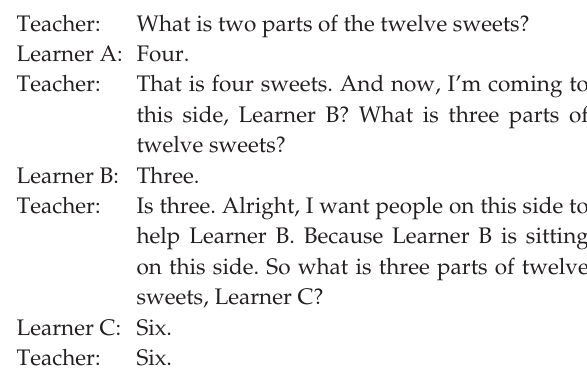
FIGURE 1: Number of mistakes dealt with by the